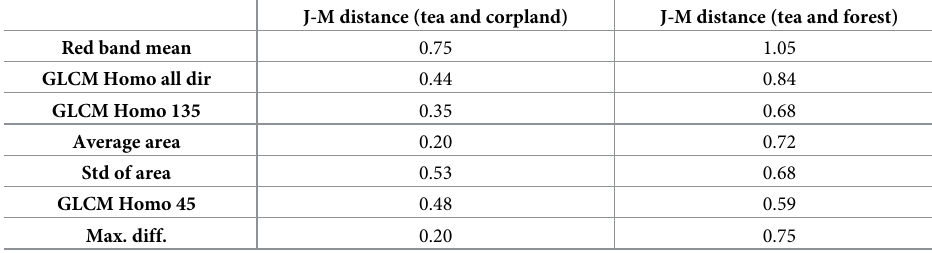
Table 3 shows the J-M distance results calculated from different features, with results sorted by value. Most features with high J-M distances are different operators based on the Gray-level cooc- currence matrix (GLCM) and Gray-level difference vector (GLDV). These features have strong discrimination but high correlation, which causes high redundancy and low accuracy. Thus, features with strong correlation coefficients should be removed. Pearson’s correlation coeffi- cient was utilized to calculate the correlation coefficients, as shown in Eqs 4 and 5: